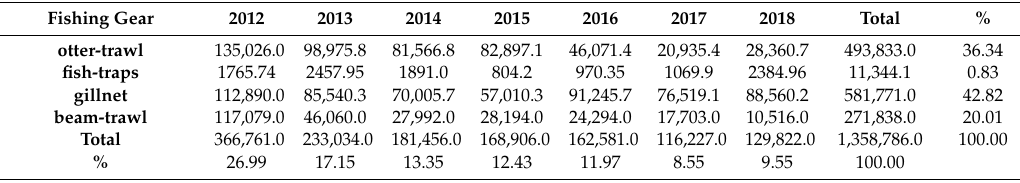
Table A2. Quantity of tons of elasmobranchs captured in the state of S ã o Paulo, Brazil from 2012 to 2018 from the Monitoring Program for the Fishing Activity of S ã o Paulo state (http: // www.propesq. pesca.sp.gov.br / ). Bottom line: the percentage of total captured by year. Final row: the percentage of total capture by fishing